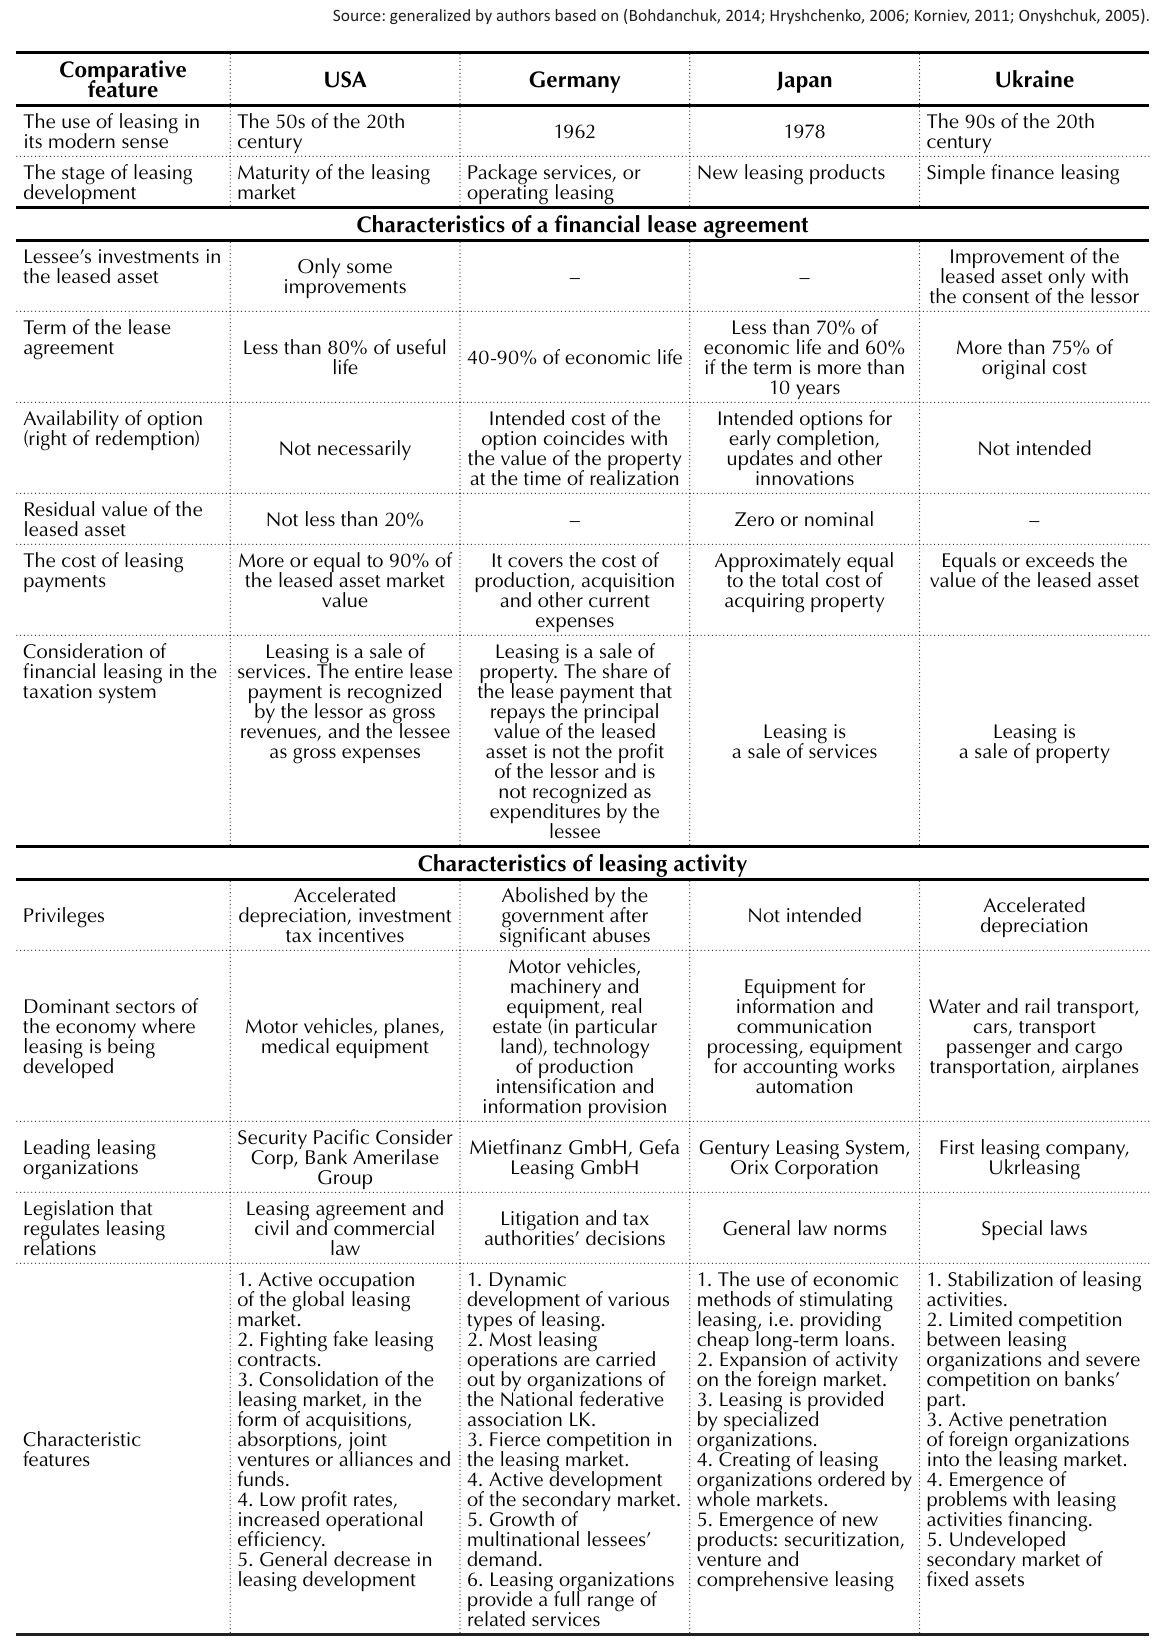
Table 2. Comparative characteristics of leasing services provision in Ukraine and in the world Source: generalized by authors based on (Bohdanchuk, 2014; Hryshchenko, 2006; Korniev, 2011; Onyshchuk,